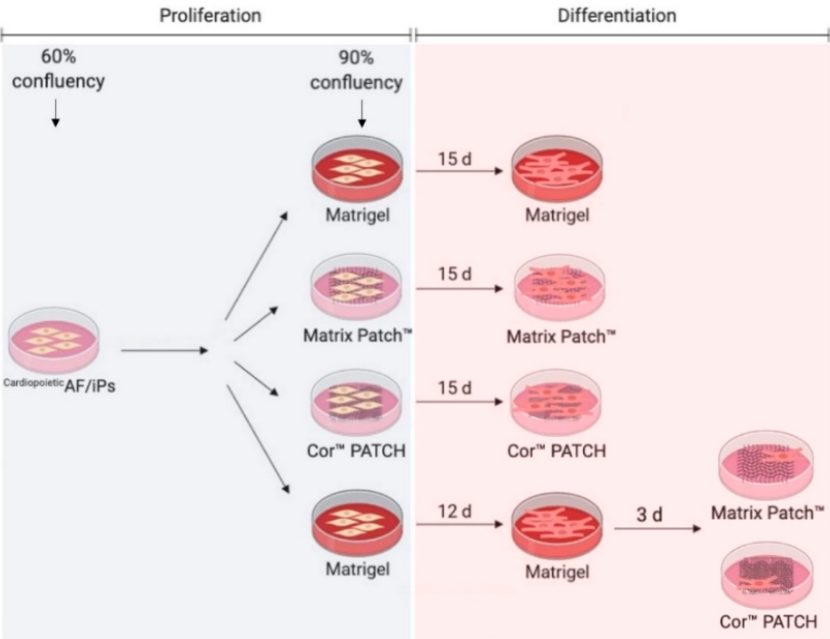
Figure 1. Scheme of the experimental design: (1) The Cardiopoietic AF and the human induced pluripotent stem cells (hiPSCs) were di ff erentiated in a monolayer for 15 days either on the Matrix Patch TM ,the Cor TM PATCH, or on the Matrigel ® control; (2) the Cardiopoietic AF and the hiPSCs were di ff erentiated in monolayer onto THE Matrigel ® for 12 days and then dissociated and moved to the Matrix Patch TM or Cor TM PATCH for 72 h.